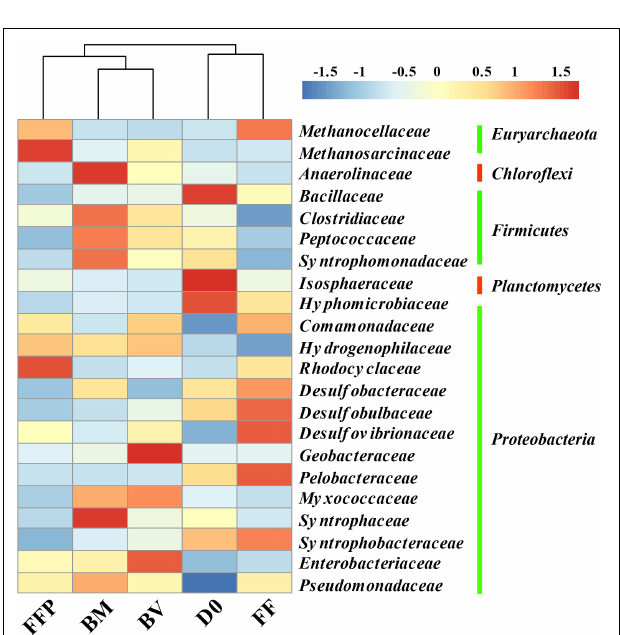
FIGURE 5 | Principal coordinates analysis (PCoA) of microbial communities in initial soil samples and acetate-fed samples based on the weighed UniFrac distance (D01–D03: triplicates of initial soil sample; FF1–FF3: triplicates of ferrihydrite-free cultures; FFP1–FFP3: triplicates of ferrihydrite-free + P cultures; BM1–BM3: triplicates of biogenic-magnetite cultures; and BV1–BV3: triplicates of biogenic-vivianite cultures).